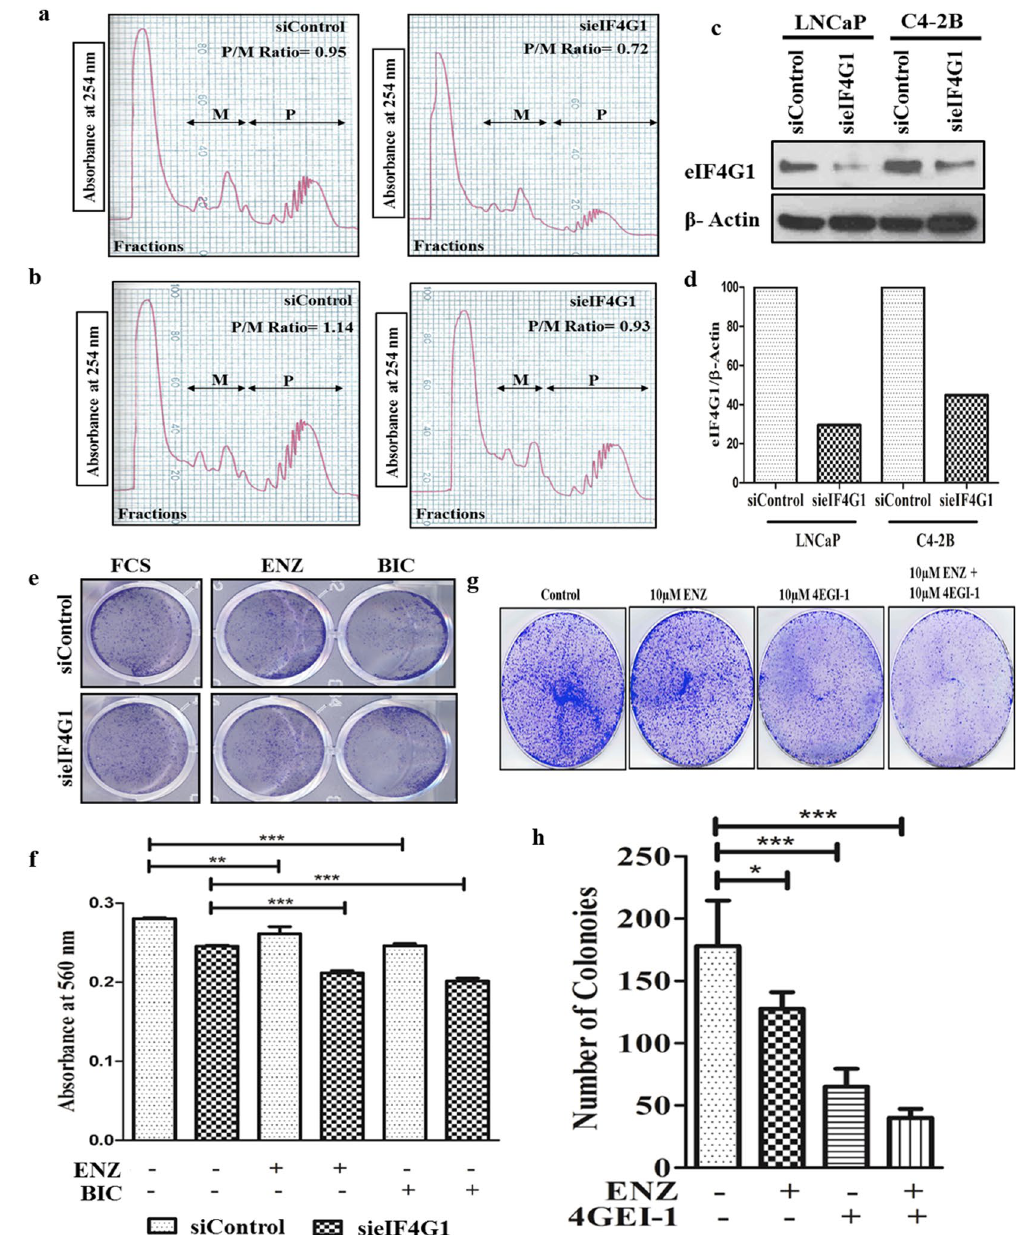
Figure 6. Knockdown of eIF4G1 impairs mRNA translation and sensitizes CRPC cells to current therapy and eIF4G complex inhibitor impairs colony formation in CRPC cells: Cytoplasmic extracts from siControl and sieIF4G1 for LNCaP ( a ) & C4-2B ( b ) cells were centrifuged respectively through continuous sucrose gradients to obtain fractions of increasing density. Absorbance ( A 254 ) (y-axis) versus increasing density (x-axis) of fractions was monitored for the presence of ribosomal subunits, ribosomes, and polysome. Polysome (P)/ Monosome (M) Ratio was calculated further. ( c ) Western blotting showing knockdown of eIF4G1 in LNCaP and C4-2B. ( d ) The graph is quantitation of western blot for eIF4G1. ( e ) Representative image of cell viability assay done by crystal violet with CRPC (C4-2B cell line) cells with siControl and sieIF4G1 treated with 10 µ M Enzalutamide (ENZ) and 10 µ M Bicalutamide (BIC) for 24 h. ( f ) The Graph showed quantitation for above plate absorbance at 560 nm. ( g ) Colony formation assay for CRPC cells (C4-2B) with 10 µ M ENZ, 10 µ M 4EGI-1 (eIF4G-eIF4E complex inhibitor) and combination of 10 µ M 4EGI-1 and 10 µ M ENZ treatment. ( h ) The graph is the number of colonies counted. Colonies were counted using an ImageJ software. Error bars represent ± SD. p-values are indicated as * < 0.05, ** < 0.01, *** <